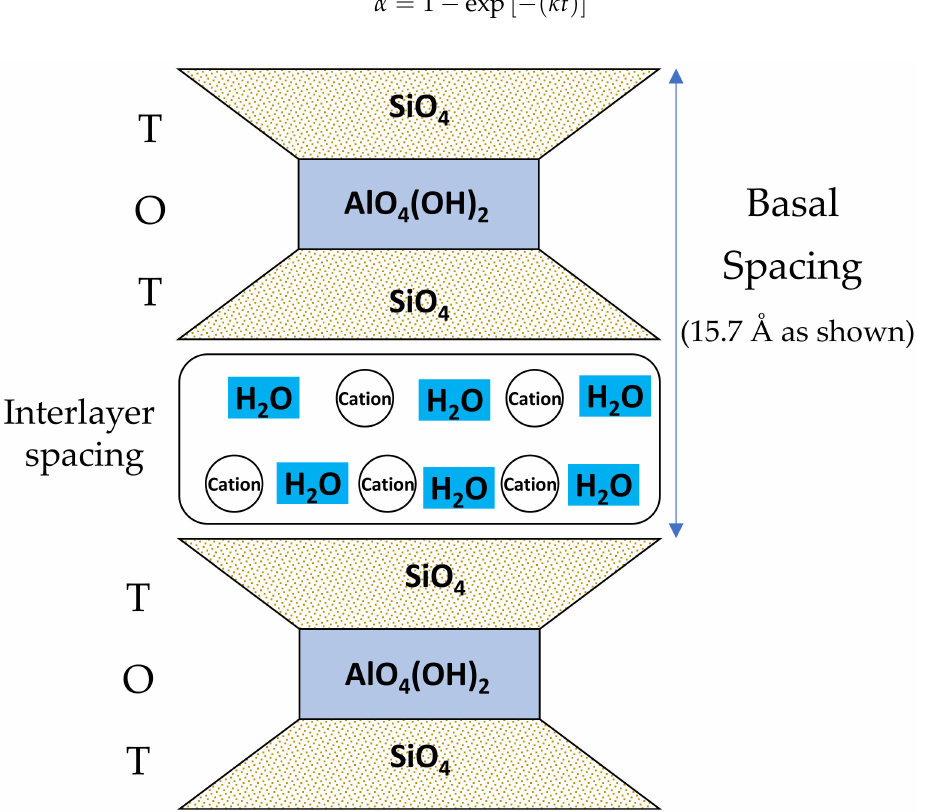
Figure 4. Schematic for the structure of the smectite mineral and two layers of water molecules in the interlayer spacing. Here, T and O denote the silicon tetrahedral sheet and alumina octahedral sheet, respectively. Cation denotes the cation ion sorption on the interlayer.